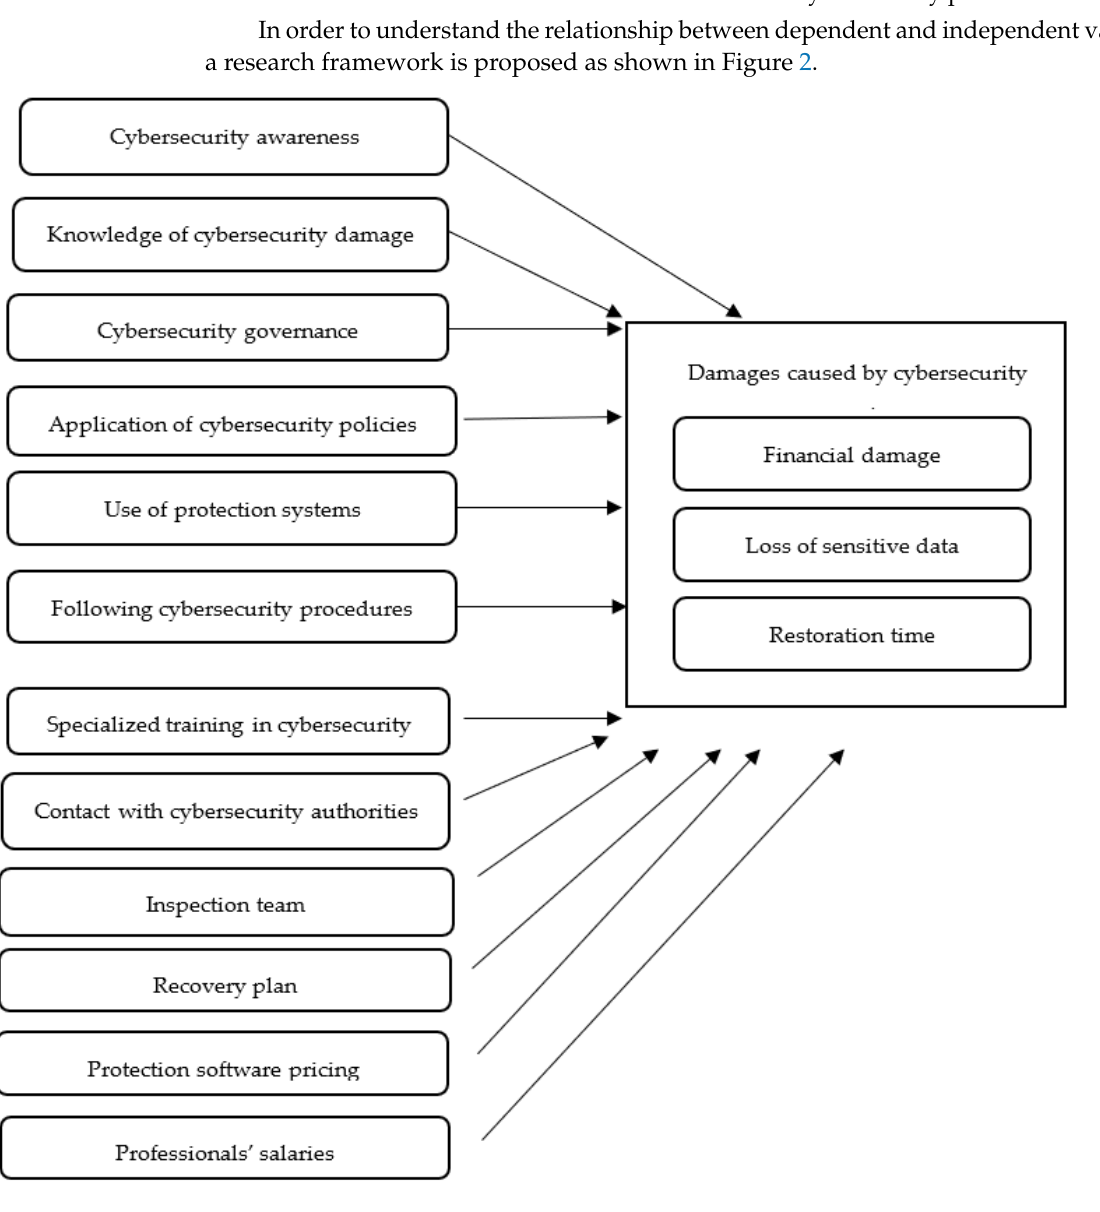
Figure 2. Research framework.